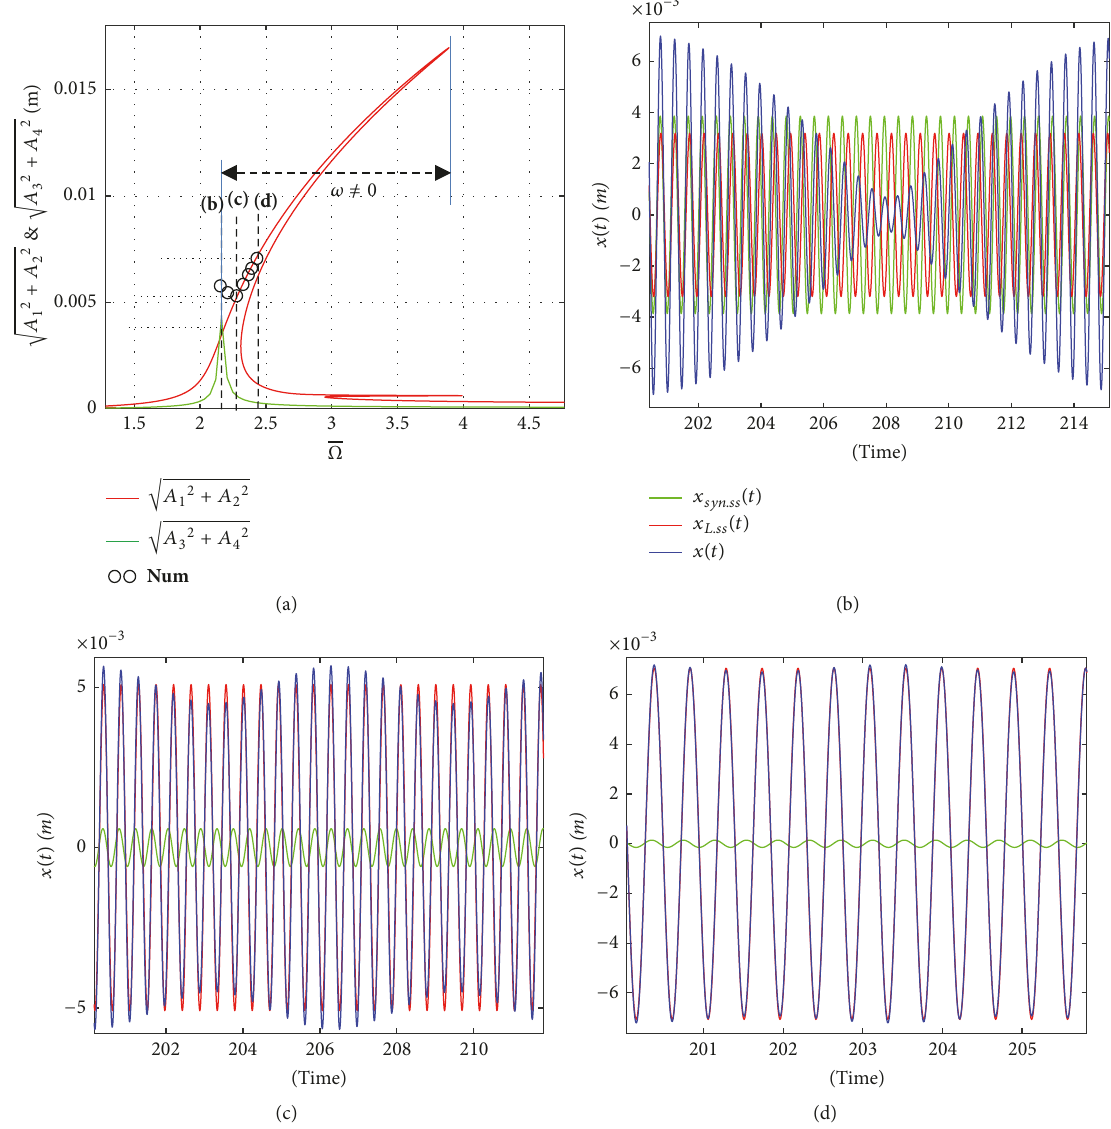
Figure 7: System behavior near resonance (b) at Ω = 2.14 , (c) Ω = 2.26 , and (d) Ω = 2.42